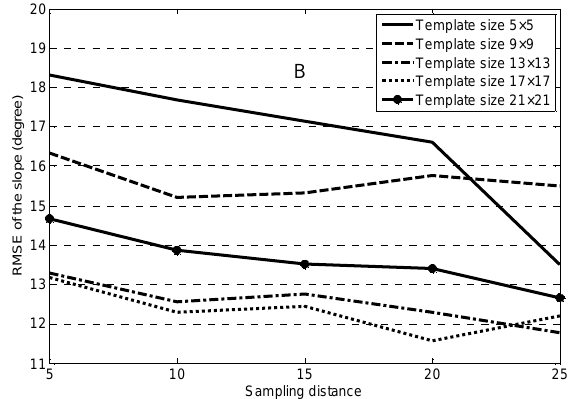
Figure 3. RMSE of the slope for different template sizes according to the sampling distance (first profile (A), second profile (B))